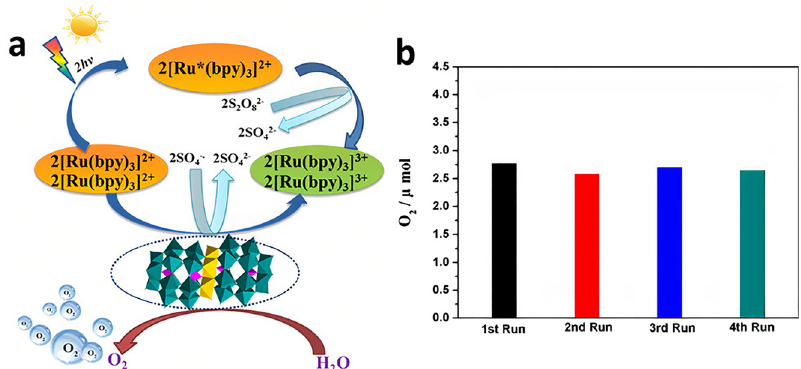
Figure 13: Mechanistic representation of